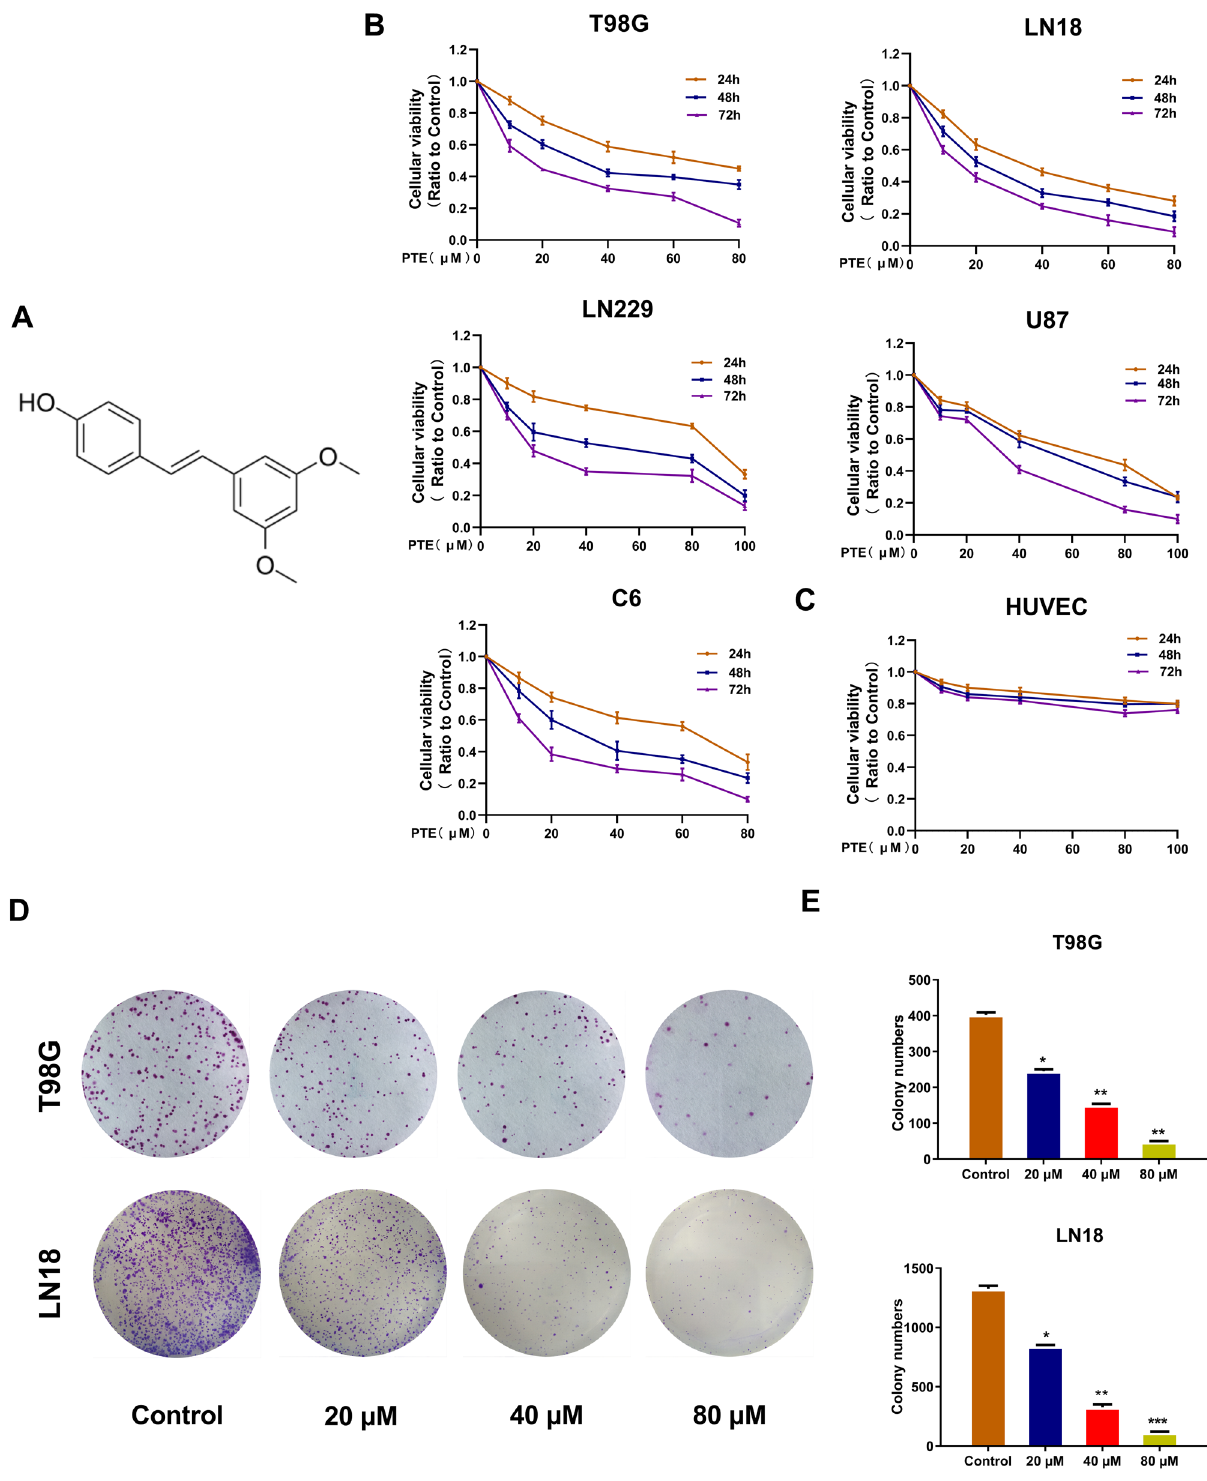
Figure 1. Pterostilbene (PTE) inhibited the viabilities of glioma cell lines. ( A )The chemical structure of PTE. ( B ) and ( C ) T98G, LN18, U87, LN229 glioma cells and HUVEC cell were treated with PTE for 24, 48 and 72 h. Cell viability was measured by MTT assay. ( D ) and ( E ) The long-term effect of PTE on the proliferative capacity of glioma cells was carried out by colony formation assays. Representative images of colony formation and analyses of the colony numbers observed in T98G and LN18 cells after 10 days of treatment with PTE at the indicated concentrations. Data are presented as the mean ± standard deviation (SD); n = 3; * p < 0.05, ** p < 0.01 and *** p < 0.001, compared to the vehicle control group. (GraphPad Prism 8.0 https:// www. graph pad.